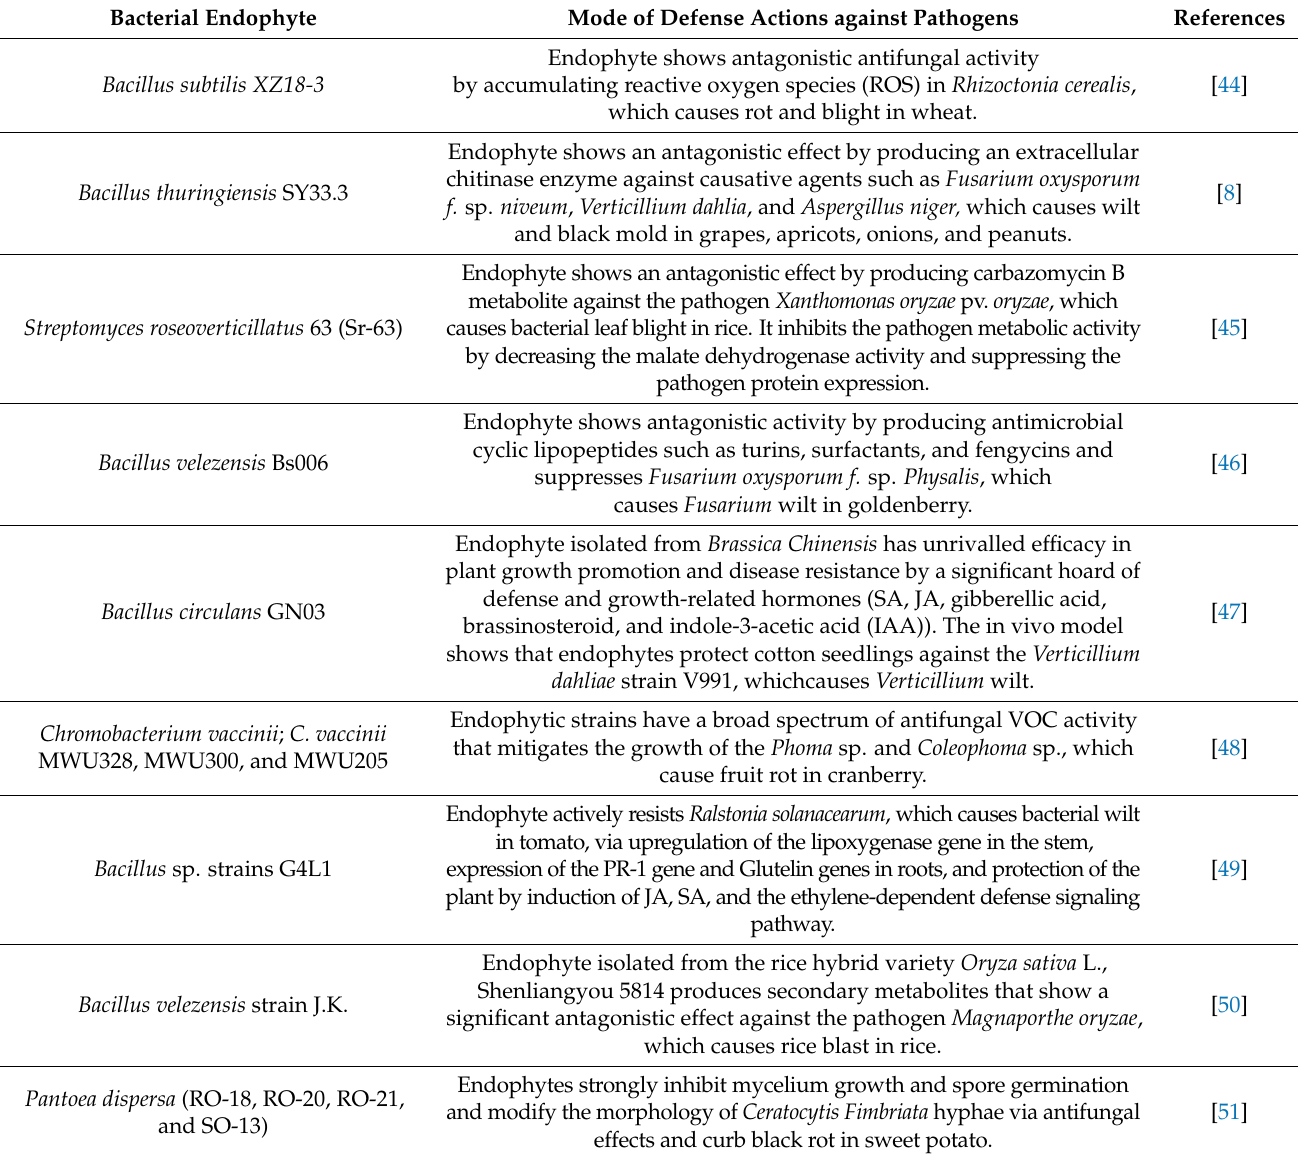
Table 3. Defense mechanism of bacterial endophytes against